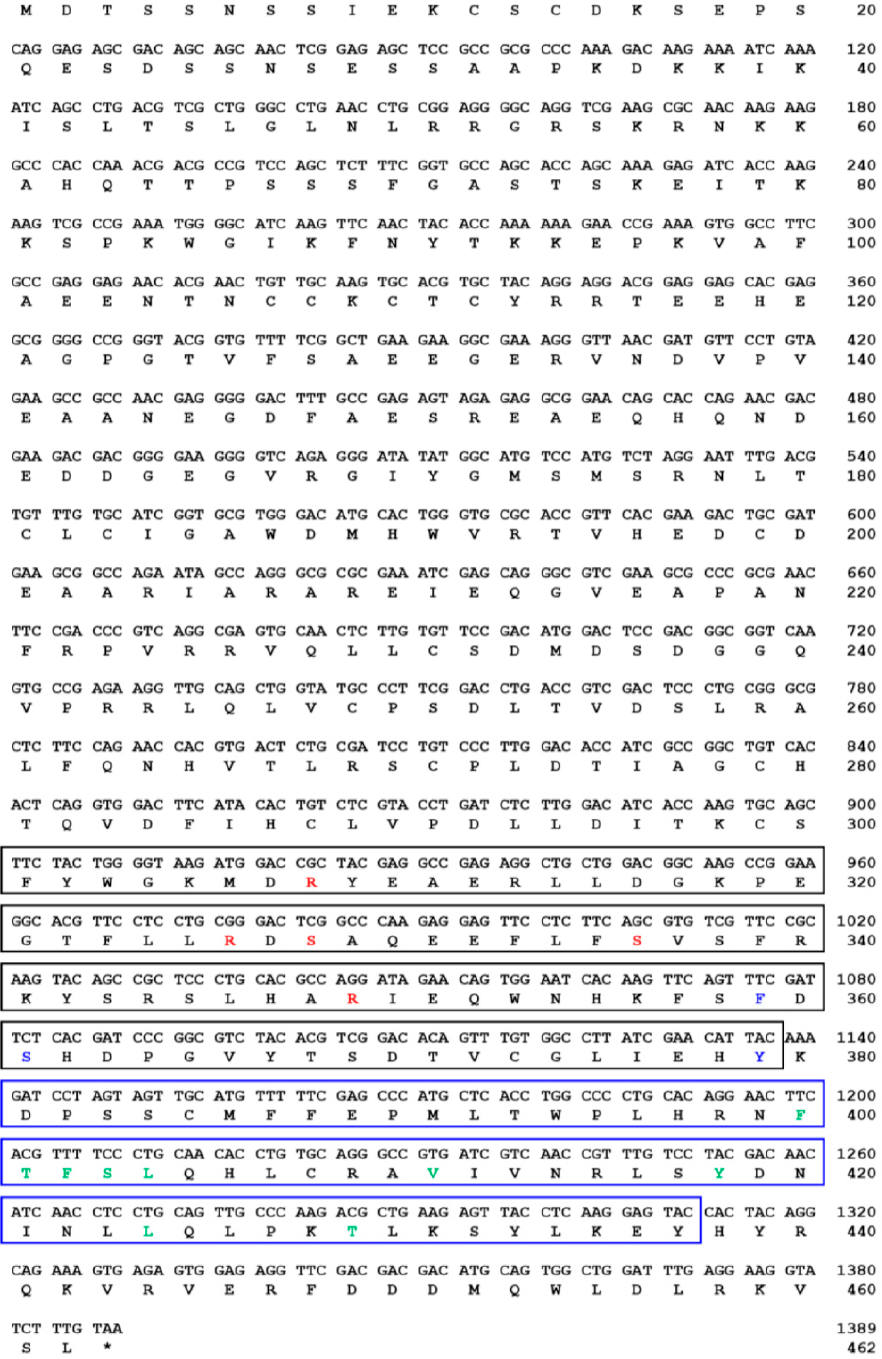
Figure 1. The nucleotide and deduced amino acid sequence of Tenebrio molitor SOCS5 (TmSOCS5). The Src Homology 2 (SH2) and suppressor of cytokine signaling (SOCS) box domains are shown in black and blue boxes, respectively. The polypeptide binding sites, including the phosphotyrosine binding pocket, hydrophobic binding pocket, and putative elongin B/C interaction residues, are shown in red, blue, and green text,